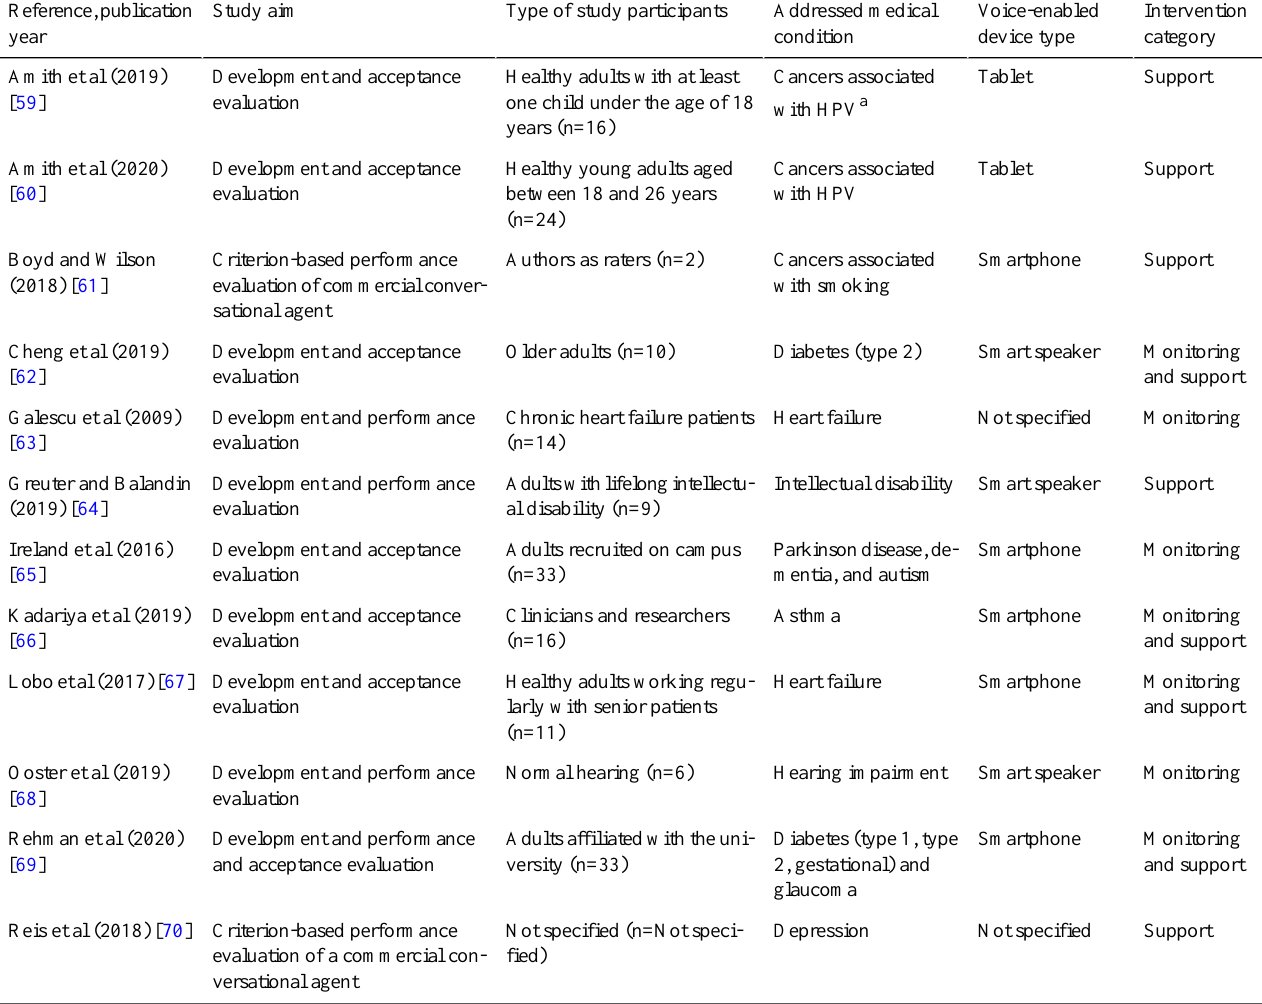
Table 1. Overview and characteristics of included